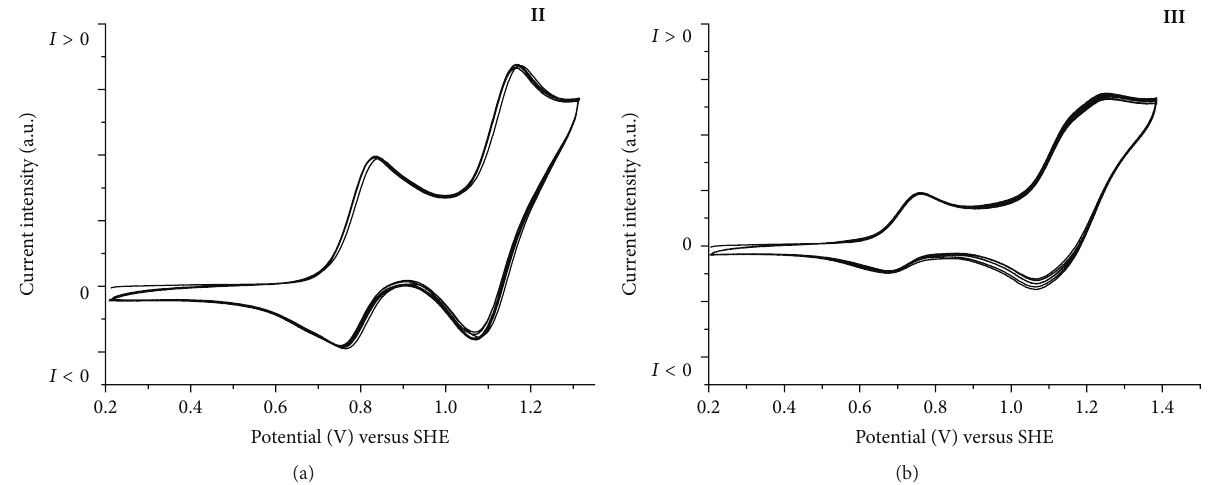
Figure 3: Cyclic voltammograms of ( a ) II and (b) III obtained from six consecutive oxidation scans.